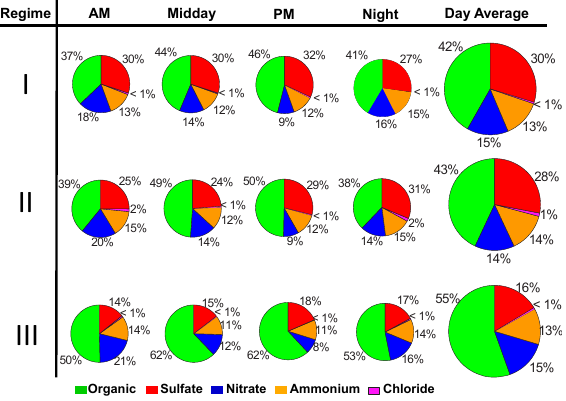
Fig. 4. AMS bulk mass fractions for AM (07:00–11:00LT), midday (11:00–15:00LT), PM (15:00–19:00LT), andnight(19:00–07:00LT)forregimesI,II,andIII.